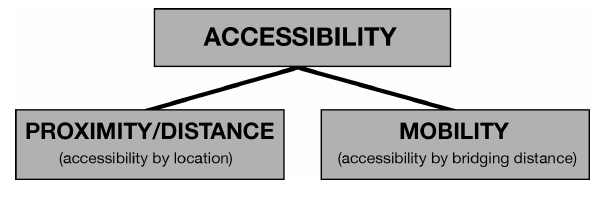
Figure 1: The interrelationship between accessibility, mobility, and